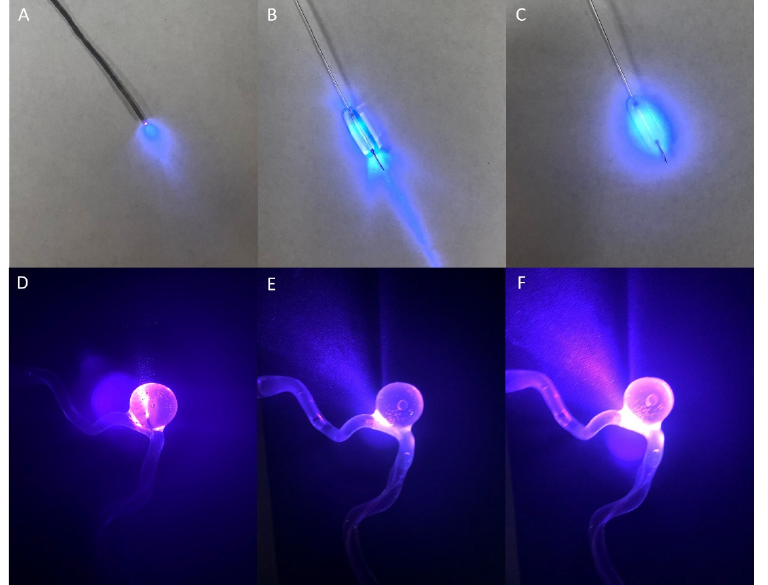
Figure 1. Light geometry associated with the different modes of light delivery, with the optical fiber threaded into the injection catheter ( A ), or into the balloon catheter inflated with contrast–saline ( B ) or contrast–saline–intralipid ( C ). Dark room view of the light irradiation within the model aneurysm presented with the injection catheter lighting ( D ) versus balloon catheter lighting without ( E ) or with ( F ) intralipid.